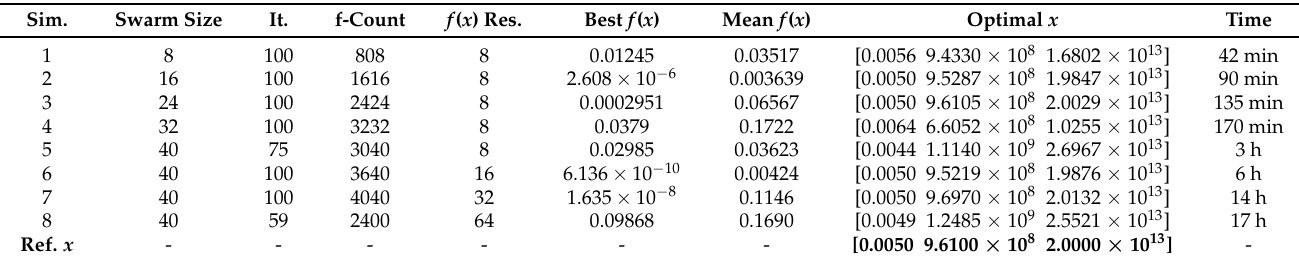
Table 2. Particle Swarm Optimization simulation summary and results. Run in a computer with Intel Core i 7-10700 processor @2.90 GHz and 16.0 GB RAM @2933 MHz, all simulations using parallelization with 8 workers.